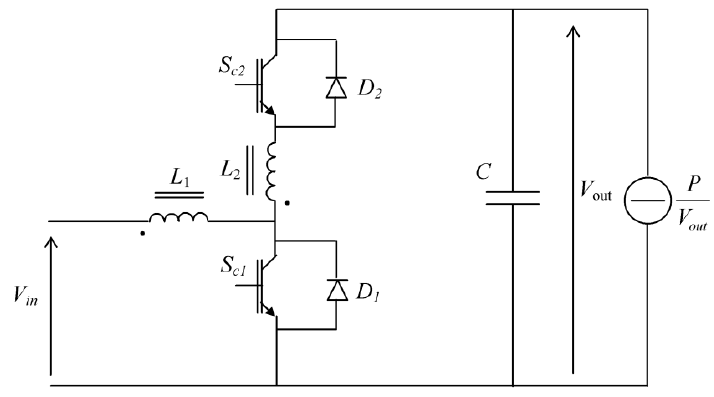
Figure 3. Coupled inductor DC–DC converter.